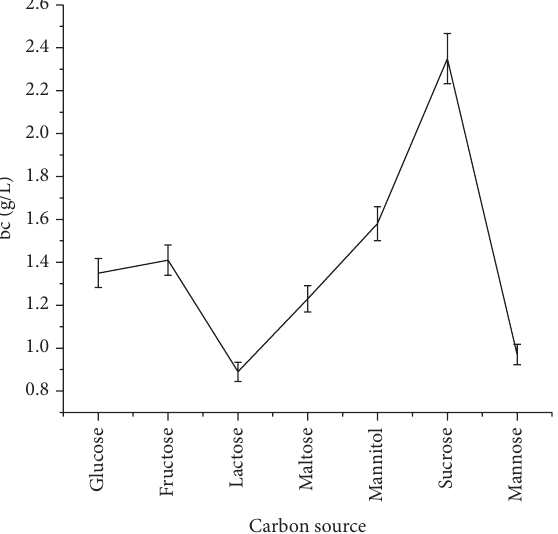
Figure 5: Effect of inoculum size on cellulose production by Gluconacetobacter sp.